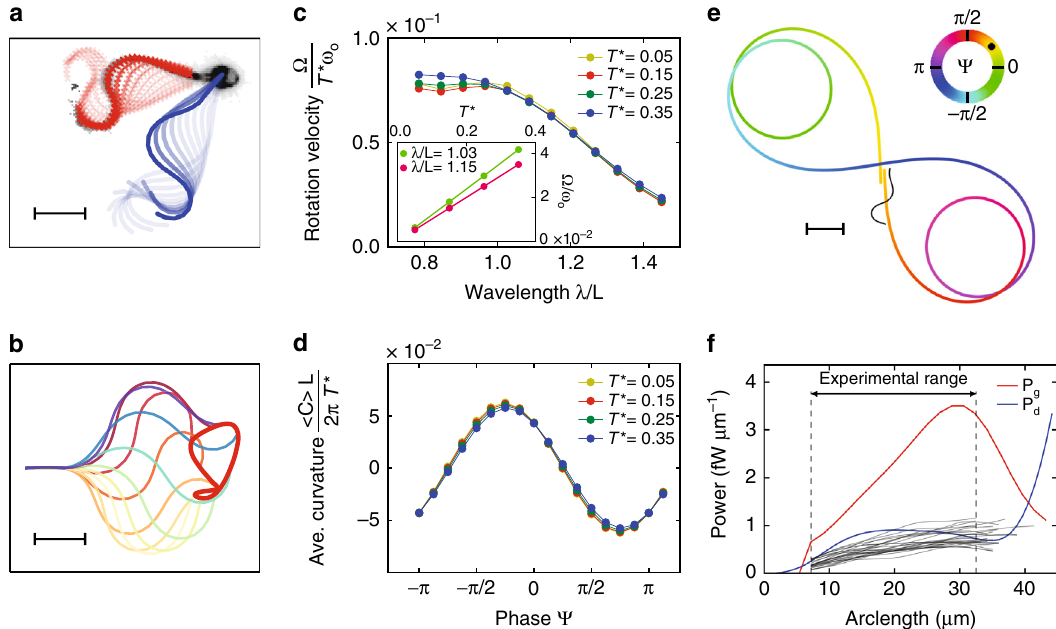
Fig. 4 Simulations reproduce the beat and steering dynamics. a Stroboscopic view of experimental (red) and simulated (blue) beat pattern using an active semi- fl exible fi lament and anisotropic drag force. Time interval between snapshots (fading lines) is Δ t = 2 ms. Simulation parameters: κ = 1.9 nN μ m 2 , T μ m, T = 0.15 T ψ = 2.26, ω = 30 Hz, L = 41 μ m, ξ ⊥ / ξ ∥ = 1.81, ξ ∥ = 0.69 fNs μ m − 2 and λ / L = 0.65 (Supplementary Movie 1). Scale bar 1 ~ 0.65 nN 2 1 , o represents 10 µ m. b Representative simulation of fl agellar beat with a second-harmonic amplitude T 2 = 0.3 T 1 . The mid-piece is aligned for visualization. The time interval between snapshots is Δ t = 4 ms. The red thick line shows the non-symmetric trajectory of the fl agellum tip. Scale bar represents 10 µ m. c Rotation velocity Ω vs. normalized wavelength λ . Note that Ω has been normalized to the second-harmonic torque amplitude. The inset shows that Ω scales linearly with T * = T T < C > vs. phase ψ of the second-harmonic torque. Note that the curvature has been normalized by 2 / 1 . d Average curvature T * = T T ψ over time (phase indicated by the color of the trajectory). By modulating 2 / 1 . e Simulated sperm trajectory resulting from a slowly changing phase the phase, sperm swim on curvilinear paths (Supplementary Movie 2). Scale bar represents 20 µ m. f Average dissipated power P d (blue) vs. generated power P g (red) in simulations, and average dissipated power measured in experiments (gray lines). The simulated dissipated power shows good agreement with the experimental results. Of note, power is relocated along the fl